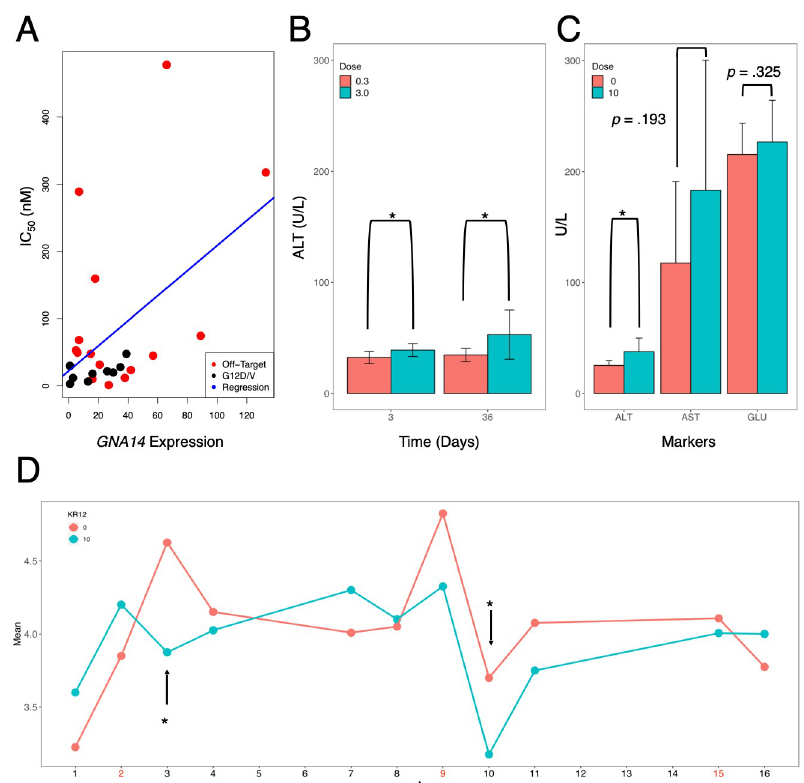
Fig 4. Side effects of polyamides targeting KRAS with G12D/V mutations. (A) Correlation of cytotoxicity of polyamide 4 to cell lines of varying KRAS codon 12 mutation status and their respective GNA14 expression. Cytotoxicity is expressed as the IC 50 concentration determined by cell proliferation assay; red points indicate cell lines with non G12D/V KRAS mutation (“off-target”); black points indicate cell lines with G12D/V KRAS mutations. R 2 for correlation model [IC 50 ] = a 0 + a 1 [GNA14]: 0.2463; with a 1 = 1.8635 ( p = 0.0116). For reference, R 2 for correlation model [IC 50 ] = a 0 + a 1 [KRAS]: 0.04128, with a 1 = -0.0430 ( p = 0.3300). (B) ALT levels of Balb/c nude mice after 3 or 36 d of exposure to polyamide 4 ; n = 4 per test condition; orange, 0.3 mg/kg polyamide 4 ; cyan, 3.0 mg/kg. (C) Serum ALT, AST and glucose levels of ICR mice as well as (D) changes in appetite over time in ICR mice treated with polyamide 4 ( n = 4 each; 0 mg/kg, orange; 10 mg/kg, cyan); red timepoints in the horizontal axis indicate points of injection. Error bars indicate mean ± SD; statistical significance is assessed by two-sample t -test; ‘ � ’, one-tailed p < 0.10. Arrows in (D) indicate days in which treatment of between 0 or 10 mg/kg of polyamide 4 showed statistical